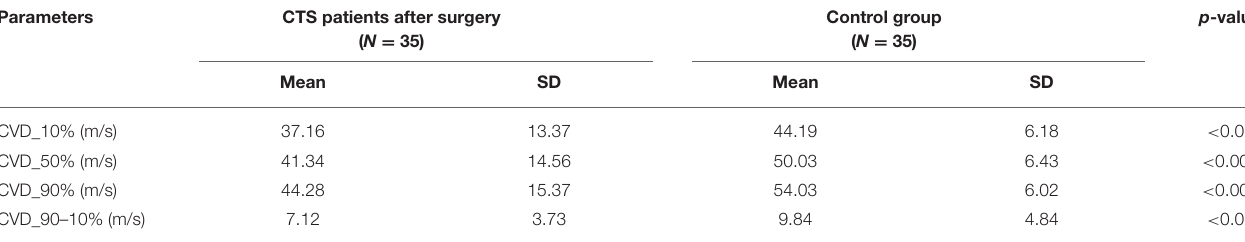
Table 4 . Logistic regression modeling for CTS severity allowed an estimation of the risk of no improvement: 3% for stage 2 on the Hi-Ob scale, 43% for stage 3, and nearly no improvement (96%) for stage 4 ( Table 5